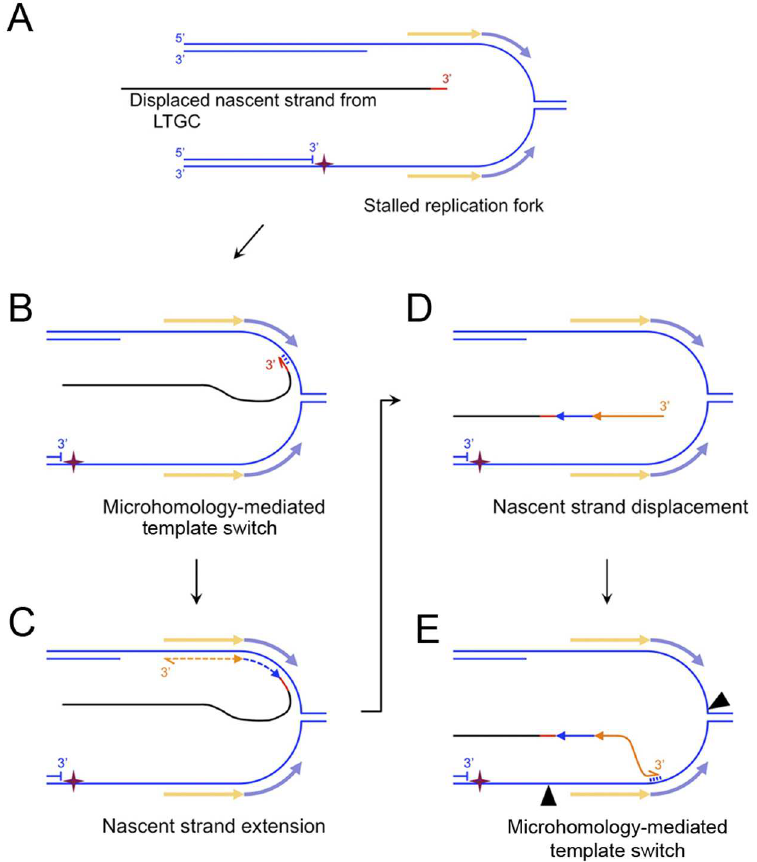
Fig 7. MMBIR model of complex breakpoint shown in Fig 6B. Strand separation occurs within the DNA of the second end of the break ~3.5 kb from the I-SceI site. One possiblesource depictedhere is a stalled replication fork. The pale orangeand blue arrows flankingthe stalled fork represent the exposedssDNA sequencesthat template the inversion(orange) and inversion-duplication(blue) sequencesidentifiedwithin the LTGC breakpoint(A) The displacednascent strand product of LTGC (black) acquires a (cid:21) 21bp insertion (red; whethertemplatedor untemplated is unknown).(B) Microhomology-mediated base-pairing betweenthe 3’ end of the displacednascent strand and ssDNA of the stalledreplicationfork. (C) The laggingstrand template enablesretrogradenascent strand extension(“MMBIR”), generatingthe inversionsequencesas shown. (D) Displacement of the nascent strand. (E) Four base pair MH-mediated (Fig 6B) annealingof the 3’ end of the displacednascent strand with the 5’ end of the duplicated regionon the leadingstrand. Black arrowheads: sites of endonucleolytic cleavagethat would enablecompletion of rearrangement by MMEJ- mediatedrejoining.Alternatively, more extensive MMBIR copyingcould completethe rearrangement.